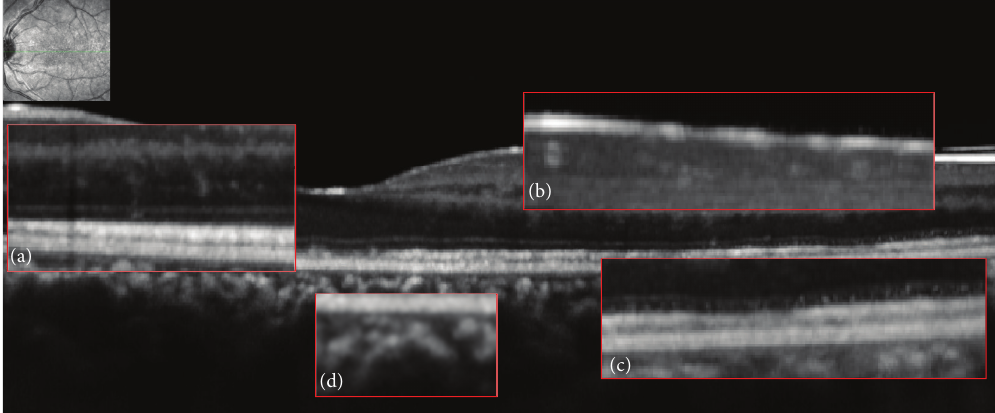
Figure 3: Hyperreflective points were observed in (enlarged views) (a) the outer nuclear layer, (b) the ganglion cell layer, (c) the myoid zone, and (d) the choriocapillaris.